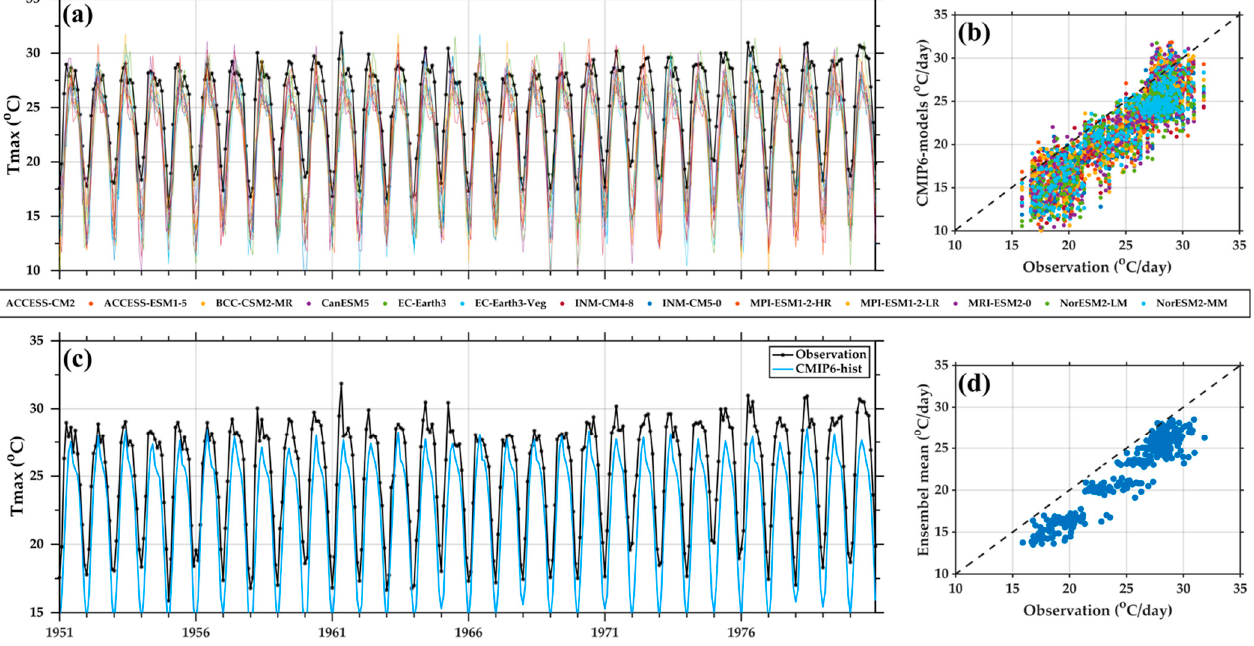
Figure A2. Performance comparison of maximum temperature from ( a , b ) observation and 13 CMIP6 models and ( c , d ) observation and mean ensemble of 13 CMIP6 models. Black dash line in panel b and d represents the 1:1 line. Note: Ensemble members in panel a and b are represented by same color.